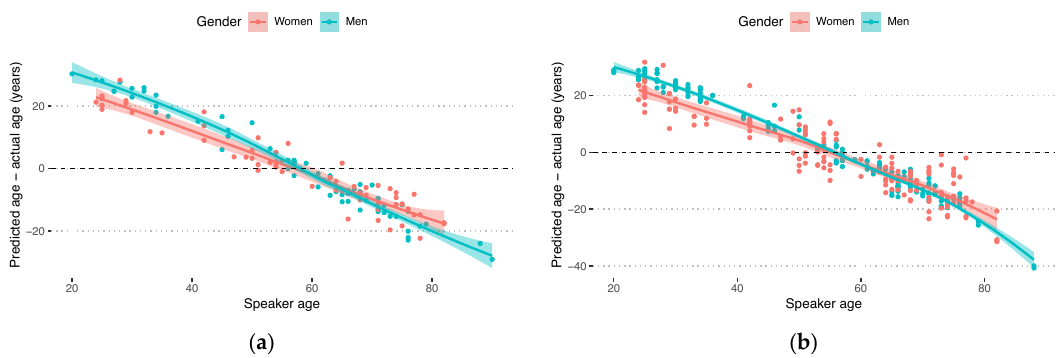
Figure 3. Errors in predicting a speakers’ age based on ( a ) the cross-validated model using acoustic measures of a sustained [a] as predictors, and ( b ) the cross-validated model in which DDK measures were used. The known age of the speaker is shown on the horizontal axis and the vertical axis shows the prediction error.